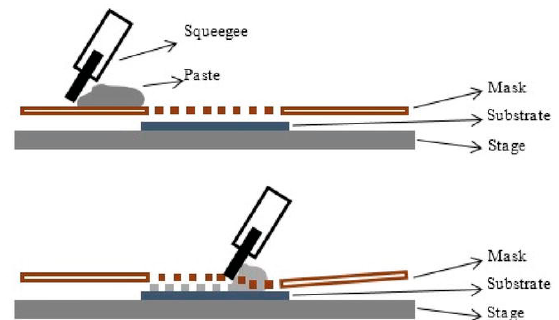
Figure 2. Schematic representation of the screen-printing process, depicting a squeegee moving on the mask, allowing for patterned deposition of the paste on the substrate placed on a solid stage. Reprinted from Reference [41], distributed under the terms of the Creative Commons Attribution 3.0 License.